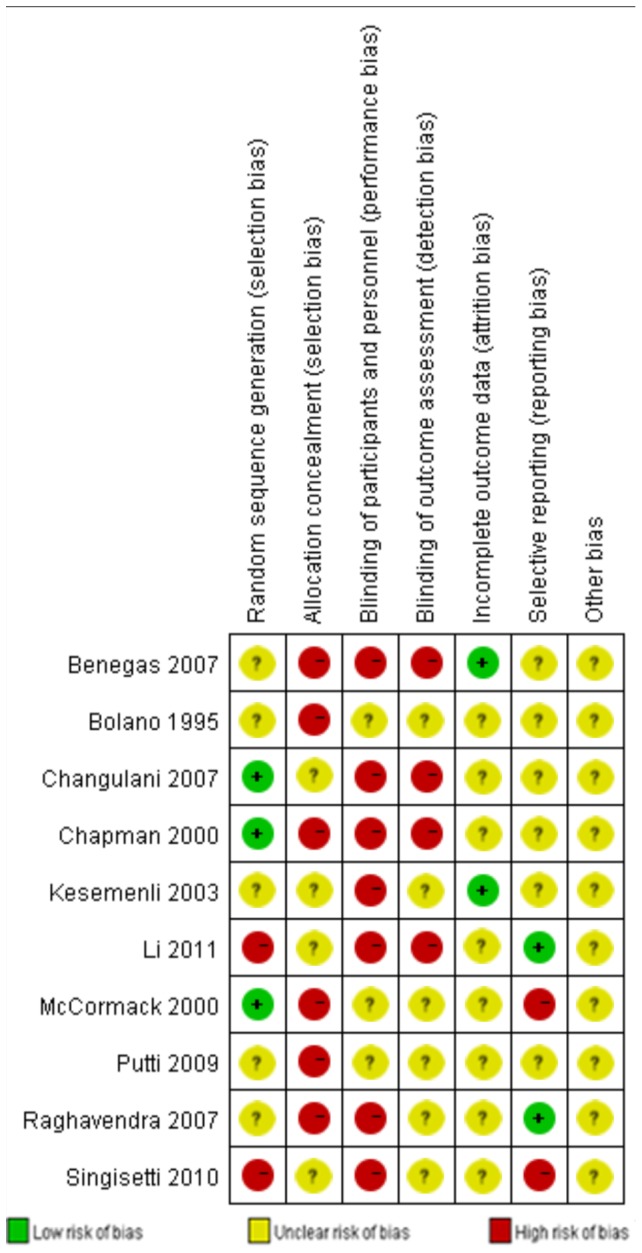
Methodological quality of the included studies.This risk of bias tool incorporates the assessment of randomization (sequence generation and allocation concealment), blinding (participants, personnel and outcome assessors), completeness of the outcome data, selection of the outcomes reported and other sources of bias. The items were scored with ‘yes’, ‘no’, ‘unsure’.